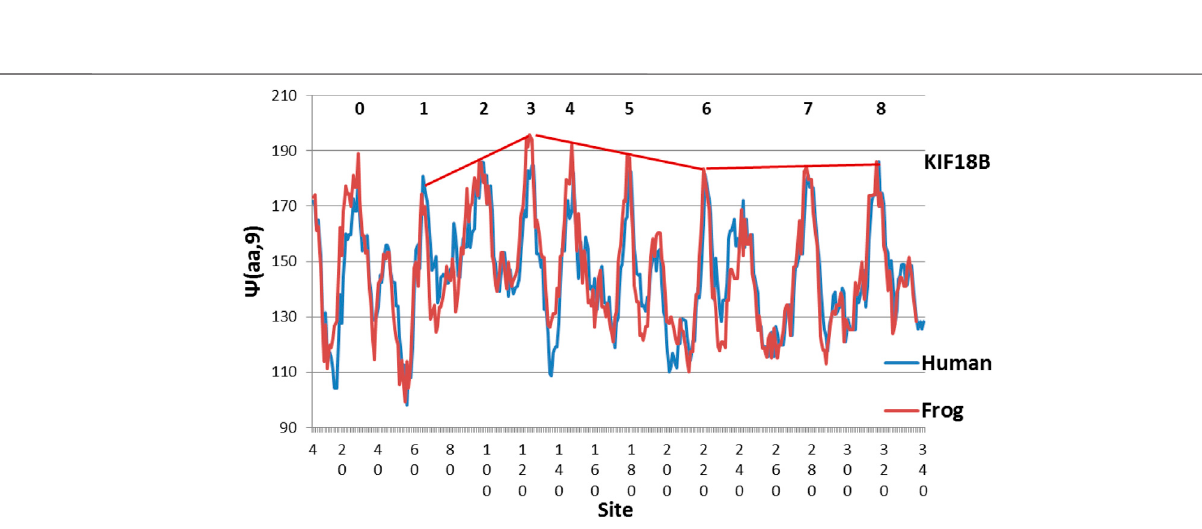
FIGURE 5 | Frog KIF18B is an extreme example, with hydrophobic peak structure peaking at Peak 3 (MZ